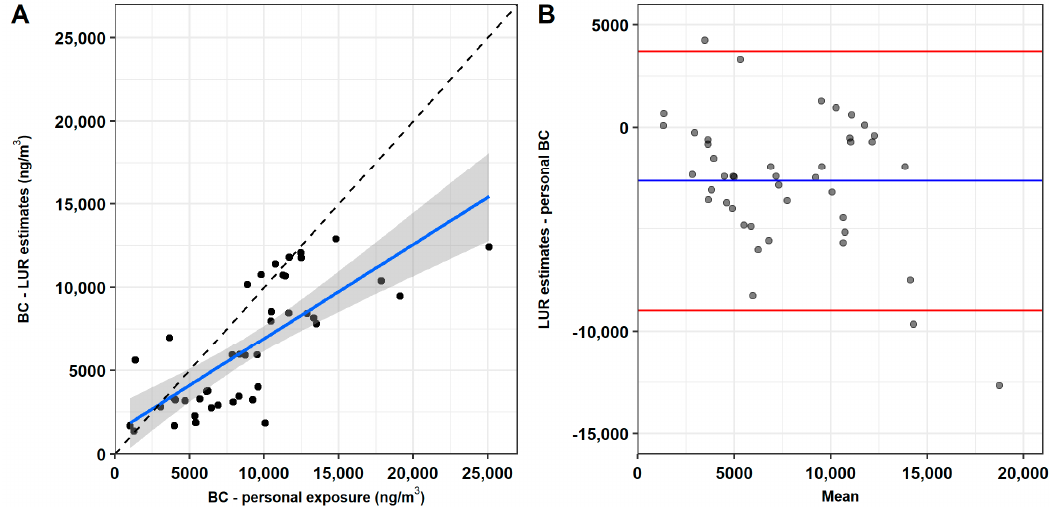
Figure 3. Correlation plot ( A ) with confidence interval set at 95% (shadowed area), and reference line (black dashed line). Bland-Altman plot ( B ) with average line (blue line), and ±1.96 SD lines (red lines). According to A, Pearson’s correlation coefficient is 0.74. In the comparison between the two methods, Lin’s Concordance Correlation Coefficient is 0.6 (95% CI: 0.43–0.74).